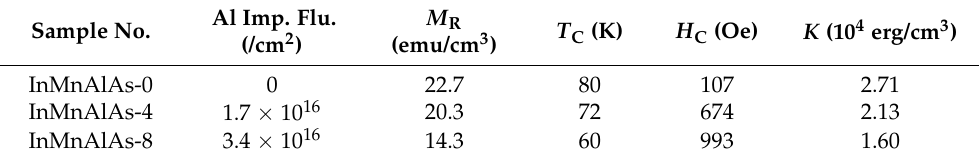
Table 1. Al implantation fluences, remanent magnetization, Curie temperature, coercivity, and anisotropy constant for the InMnAlAs-0, InMnAlAs-4, and andInMnAlAs-8 samples. Sample